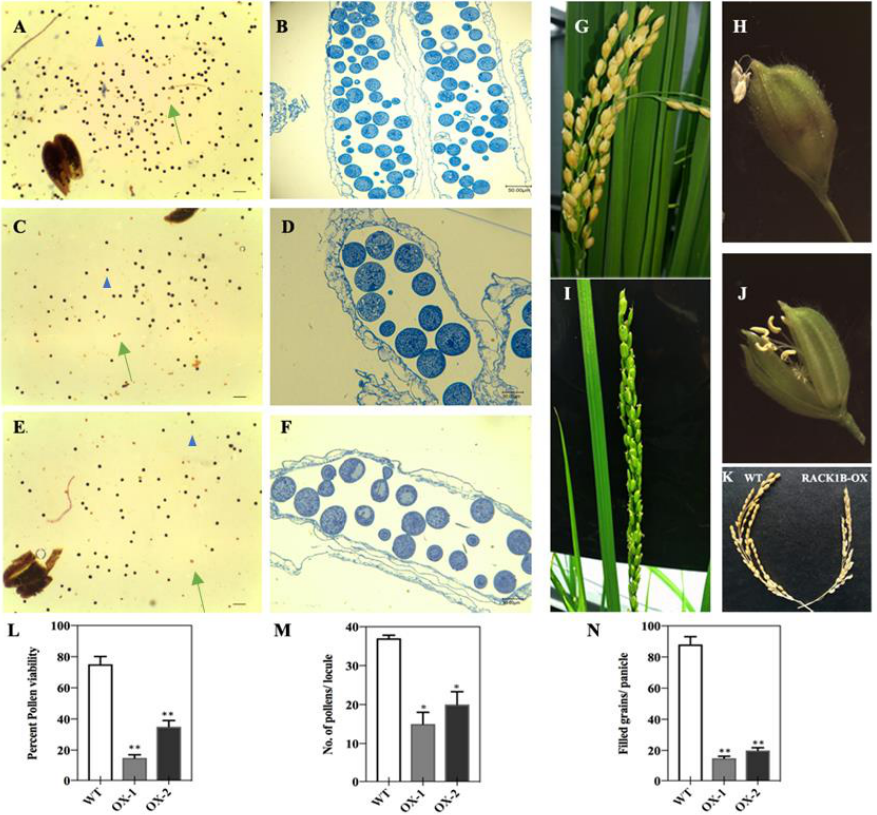
Figure 5. Analysis of the pollen phenotype from wild-type (WT) and OsRACK1B-OX transgenic plants. ( A , C , E ), KI-I 2 staining showing reduced pollen viability in the OX-1 ( C ) and OX-2 ( E ) plants compared to that of the WT plant ( A ). Blue arrowheads indicate normal pollen (deep purple color grains), while green arrows indicate abnormal pollen (weak red color grains). Percentage pollen viability ( L ) was calculated based on the different colors of pollens from ( A , C , E ). Bars = 100 µ m. ( B , D , F ), transverse section analysis of single locule form anther of WT ( B ), OX-1 ( D ), and OX-2 ( F ). Anthers were stained with toluidine blue at mature pollen stage. Number of pollen grains per locule was calculated ( M ). Bars = 50 µ m. ( G , I , K ) Panicles of WT ( G ) and OsRACK1B-OX ( I ) plants. M, quantitative analysis of grains per locule of anthers from WT and RACK1B-OX plants. ( H , J ) Spikelet phenotype of WT ( H ) and OsRACK1B-OX ( J ) plants. ( K ) Panicle phenotype of WT and RACK1B-OX plants. No. of filled grains per panicle was calculated ( N ). Data are means ± SEM of three biological replicates. Singleand double asterisks indicate statistical significance: * p < 0.05, ** p < 0.01, respectively, compared to wild-type (Student’s t